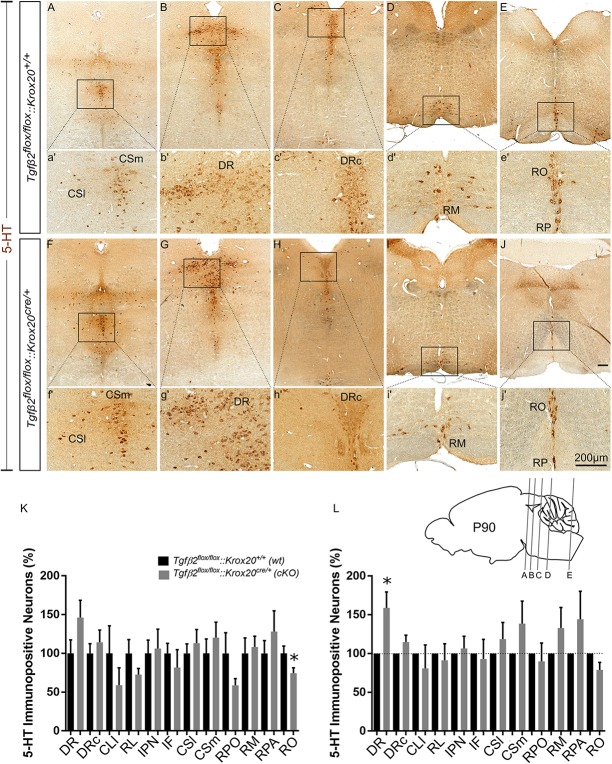
Phenotype analysis of Tgfβ2flox/flox:Krox20cre/+ hindbrain in adult mice. Immunoperoxidase light microscopy for the serotonergic neuron subgroups (5-HT positive) DR (B,G), caudal part of the dorsal raphe (DRc, C,H), superior central linear nucleus lateral part (CSl, A,F), superior central linear nucleus medial part (CSm, A,F) and of the caudal serotonergic neuron subgroups RM (D,I) RO (E,J) and raphe pallidus (RPA, E,J) of Tgfβ2flox/flox:Krox20cre/+ in 3 month old mice. (a′–j′) Represent higher magnification of the respective black-boxed areas in (A–J). Counting of 5-HT-positive (K,L) cells after immunostaining in hindbrain fixed tissue sections, ∗p < 0.05, using the Welch corrected unpaired or unpaired two-tailed Student’s t-test n = 5–8. Data are given as mean ± SEM, the mean of wt was set to 100 (K) or the mean of wt littermate was set to 100 (L). Scale bar: 200 μm.